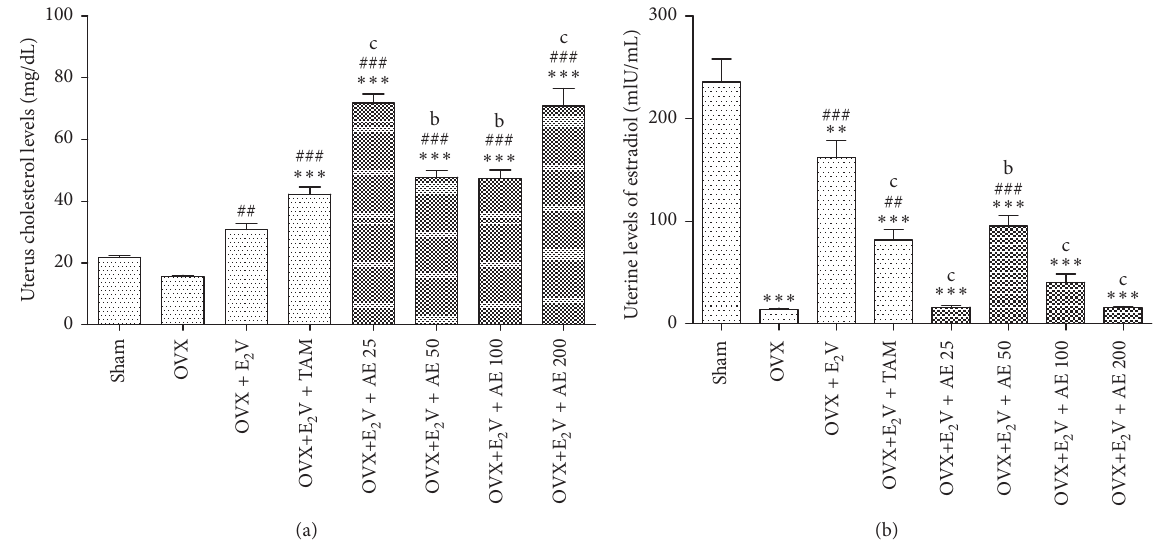
Figure 4: Effects of treatments on uterine levels of total cholesterol (a) and estradiol (b). SHAM: sham-operated animals; OVX: ovariectomized animals; E 2 V: estradiol valerate; TAM: tamoxifen; AE: aqueous extract of D. edulis leaves. Data are presented as mean ± S.E.M. ( n � 6). ∗∗ p < 0 . 01 and ∗∗∗ p < 0 . 001 compared with SHAM; ## p < 0 . 01 and ### p < 0 . 001 compared with OVX; and b p < 0 . 01 and c p < 0 . 001 compared with OVX+E 2